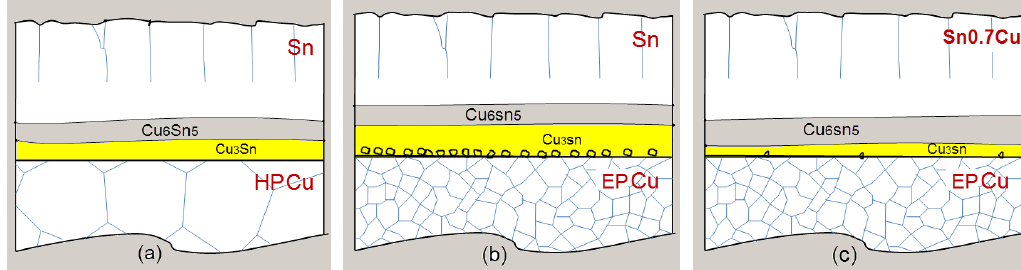
Figure 7. Schematic drawings showing the general process for interfacial behavior in Sn/HP Cu ( a ), Sn/EP Cu ( b ), and Sn0.7Cu/EP Cu ( c ) systems.